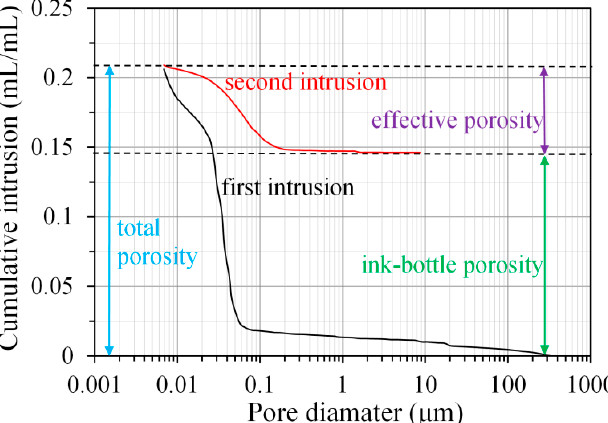
Figure 2. Typical cumulative pore size distribution curves obtained from the first and second intrusion process in mercury intrusion porosimetry (MIP)